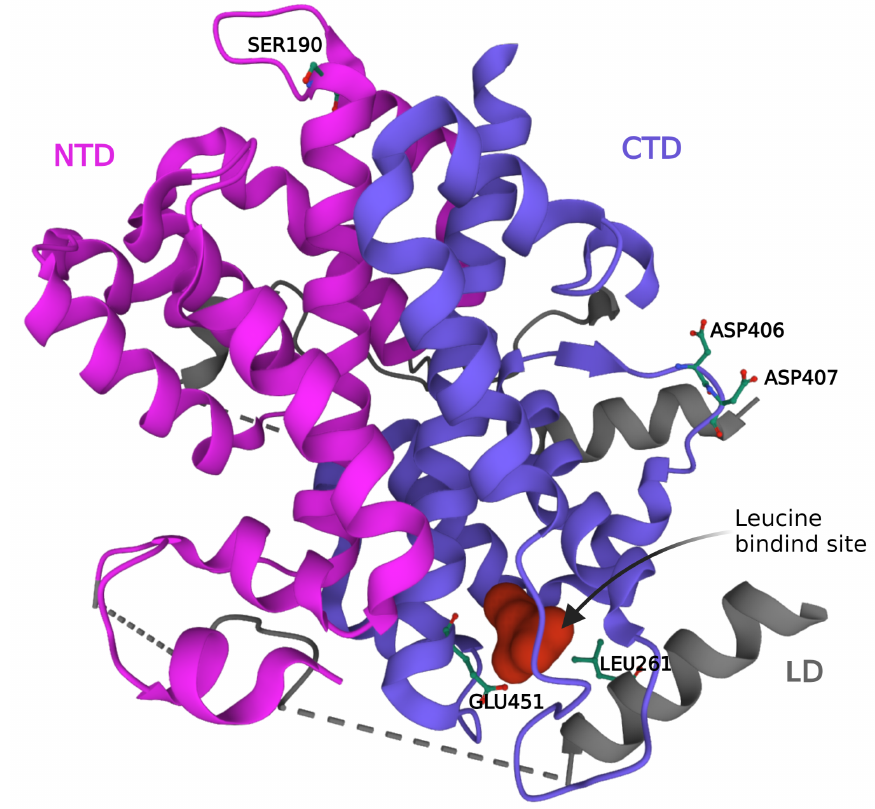
Figure 1. Leucine bound structure of SESN2 (PDB 5DJ4). The protein consists of an NTD and CTD joined together by a small LD. The leucine binding site is present in the CTD. The residues important for leucine binding (GLU451 and LEU261) and the interaction of GATOR2 (ASP406-407 and SER190) with SESN2 are labeled. CTD: C-terminal domain; LD: Linker domain; NTD: N-terminal